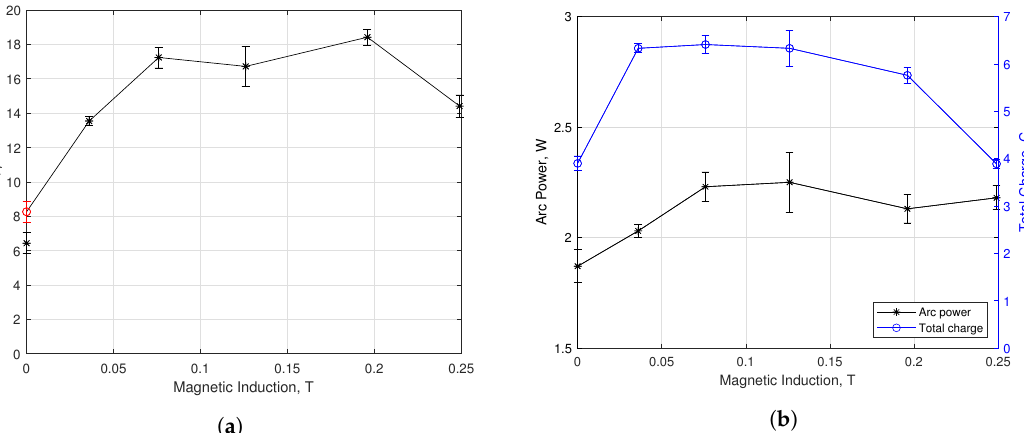
Figure 12. Average thrust versus magnetic induction. B = 0 “no coil” result is indicated in red ( a ). Average arc power and total charge versus magnetic induction ( b ).